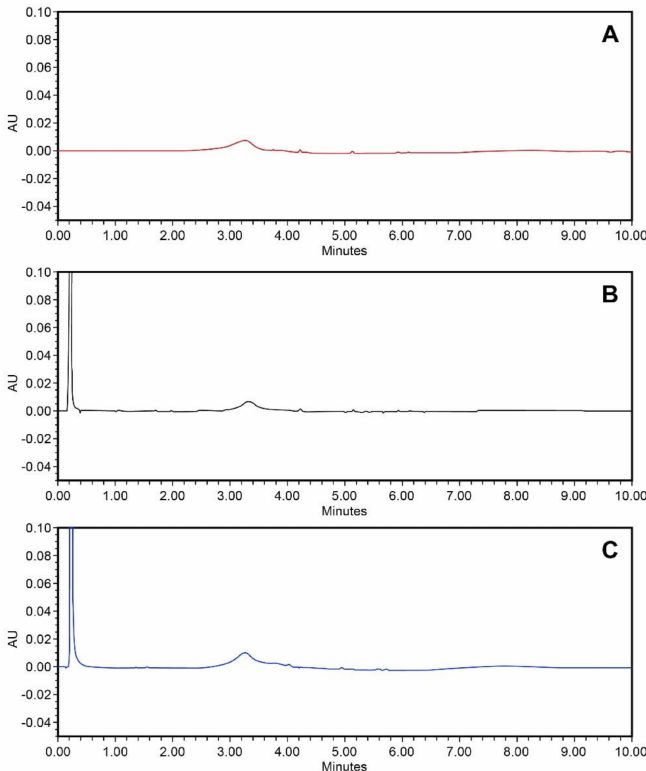
Figure 6. Chromatogram at 280 nm of mobile phase ( A ), blank ( B ) and placebo ( C